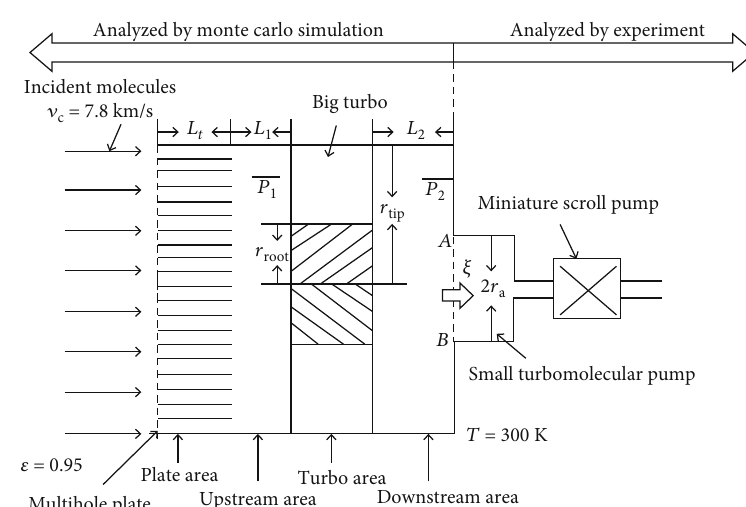
Figure 11: Schematic diagram of a vacuum air-intake device [36].